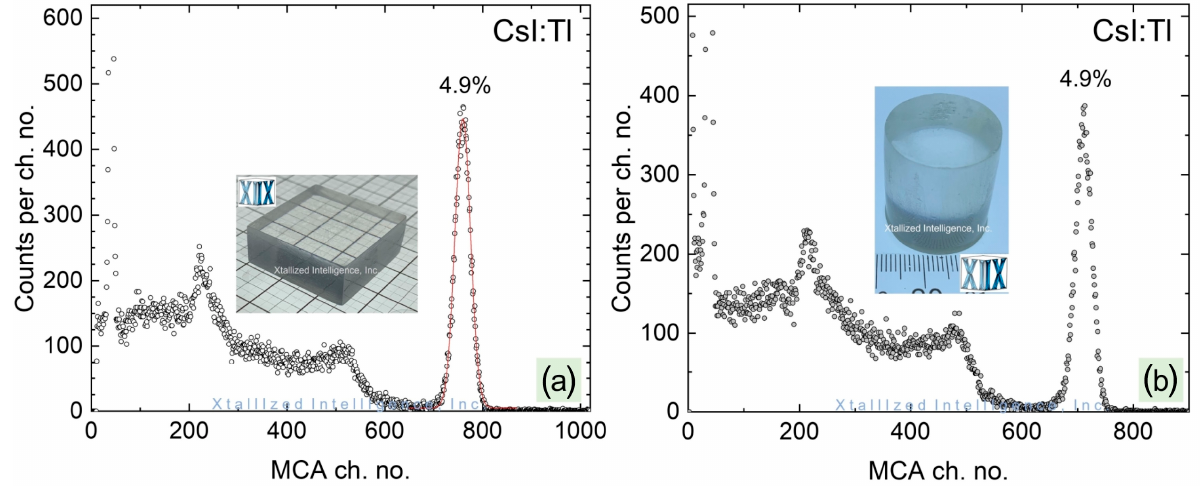
Figure 2. ( a ) 137 Cs spectrum collected by a 30 × 30 × 10 mm 3 cuboid CsI:Tl (4.9% (FWHM)) at 662 keV and light yield of 86,000 photons/MeV). ( b ) 137 Cs spectrum collected by a ∅ 1” × 1”cylindrical CsI:Tl (4.9% (FWHM)).